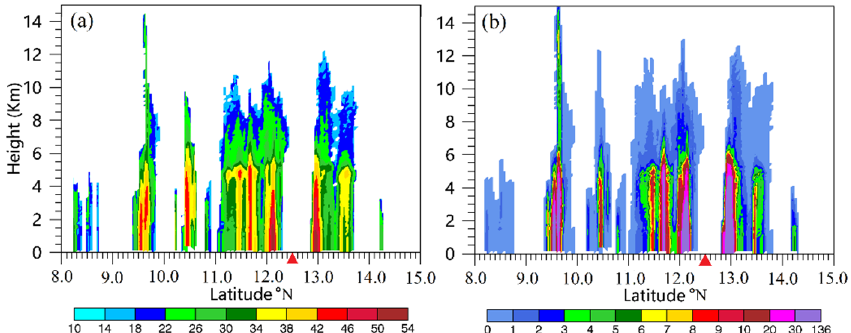
Figure 5. Latitudinal height sections of ( a ) the reflectivity (dBZ) and ( b ) precipitation intensity (mm·h − 1 ) from the GPM-DPR data along the satellite track crossing the typhoon center at 17:00 on 6 July (the cross line between the section and the Earth is the solid red line in Figure 3d; the latitude of the TC center is marked with a red triangle beneath the x-coordinate).